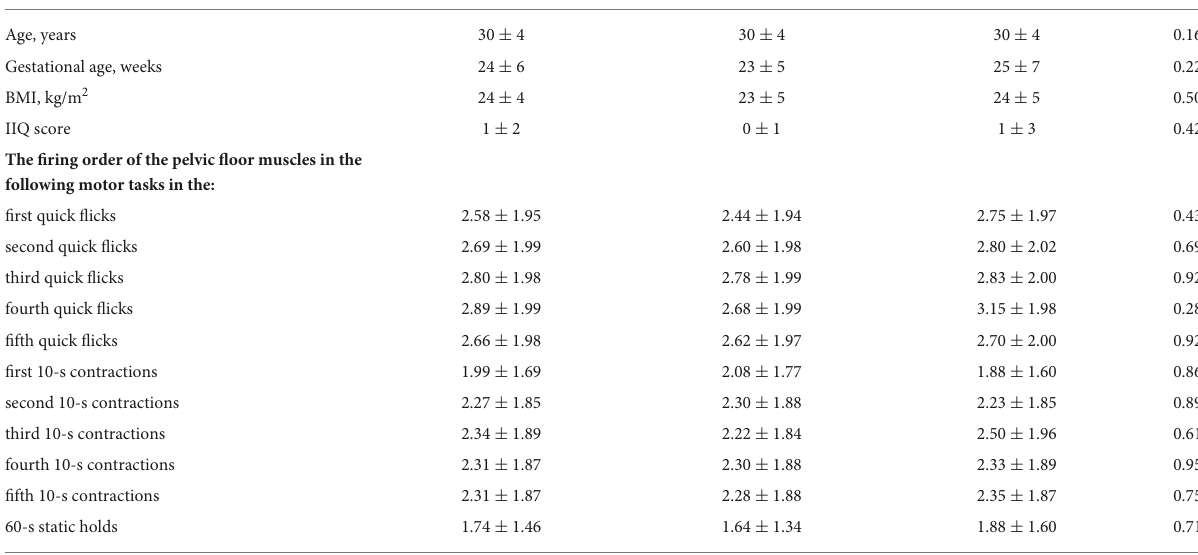
TABLE 1 Characteristics of the study groups.